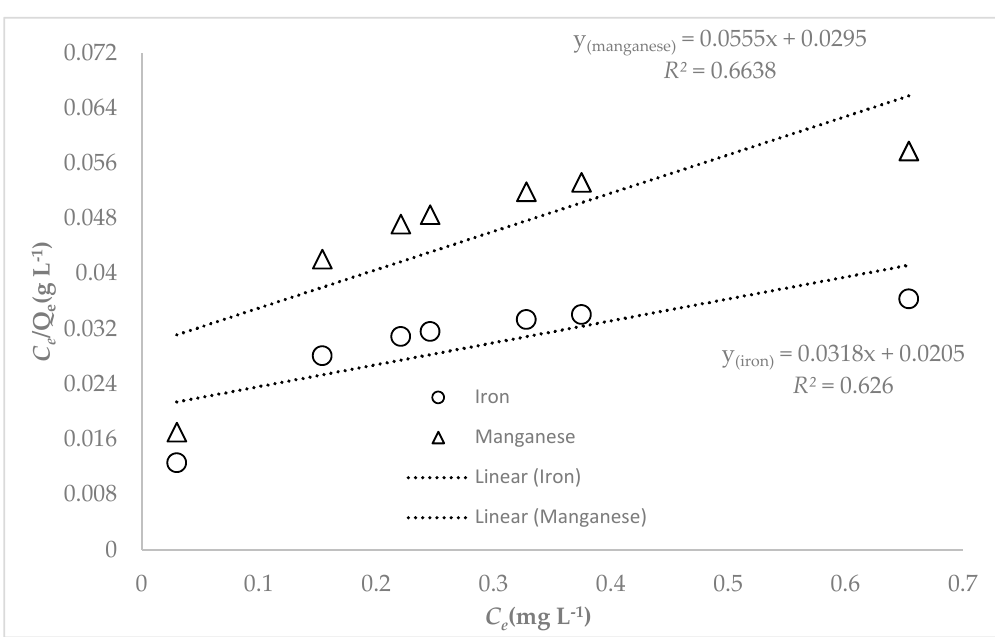
Figure 8. Non-linearized Langmuir adsorption isotherms obtained for the iron and manganese uptake onto zeolite Y during the adsorption studies. Initial Fe = 1.15 mg L − 1 ; Initial Mn = 1.61 mg L − 1 ; adsorbent dose = 1.0, 2.0, 2.5, 3.0, 3.0, 4.0 and 4.5 g L − 1 , T = 25 ◦ C; water pH = 6.5.